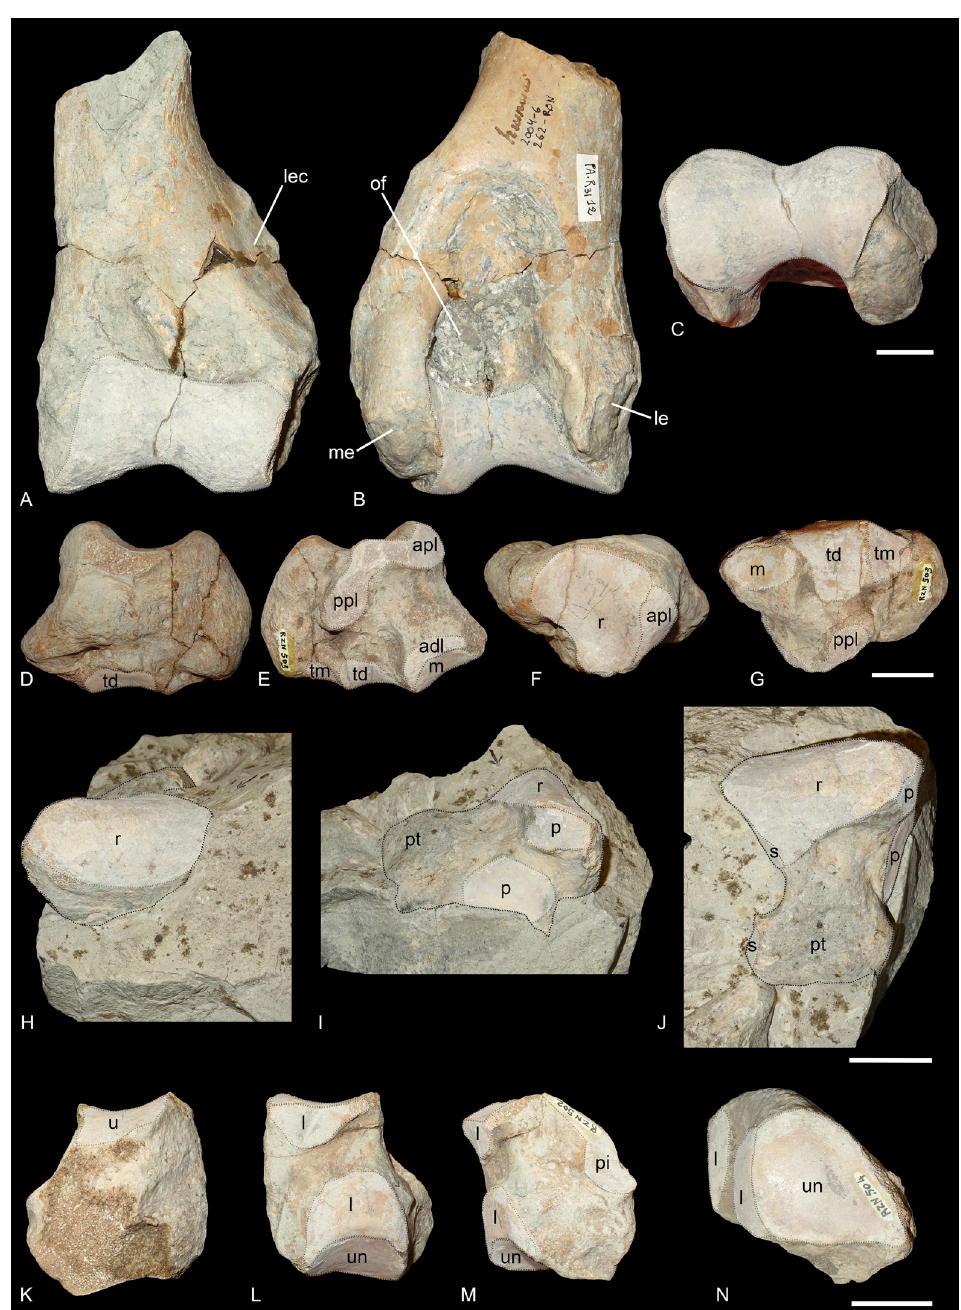
Fig. 4. Ronzotherium velaunum (Aymard in Pictet, 1853) from Ronzon (earliest Oligocene, France). – A–C . Left distal humerus PUY.2004.6.262.RON. A . Anterior view. B . Posterior view. C . Distal view. – D–G . Right scaphoid MNHN.F.RZN.503. D . Medial view. E . Lateral view. F . Proximal view. G . Distal view. – H–J . Right lunate PUY.2004.6.1901.RON. H . Anterior view. I . Lateral view. J . Proximal view. – K–M . Right pyramidal MNHN.F.RZN.502. K . Lateral view. L . Medial view. M . Posterior view. – N . Left pyramidal MNHN.F.RZN.504, distal view. Abbreviations: adl = anterodistal facet for the lunate; apl = anteroproximal facet for the lunate; l = lunate; le = lateral epicondyle; lec = lateral epicondylar crest; m = magnum; me = medial epicondyle; of = olecranon fossa; p = pyramidal; pi = pisiform; ppl = postero-proximal facet for the lunate; pt = posterior tuberosity; r = radius; s = scaphoid; td = trapezoid; tm = trapezium; u = ulna; un = unciform. Articular surfaces highlighted in white. Scale bars: 2